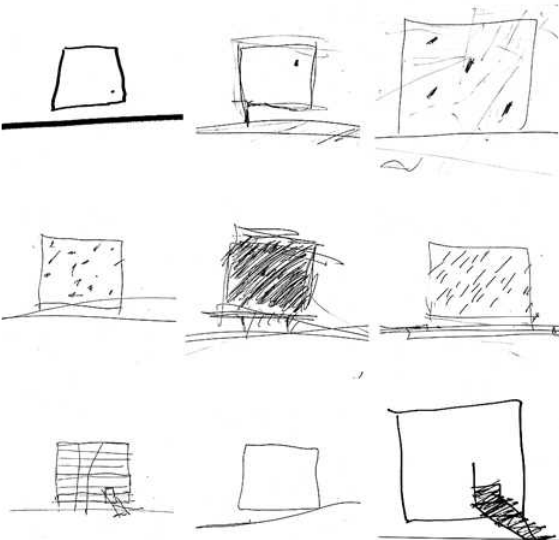
Fig. 20. Prosecutor's Office building sketches, Vilnius.